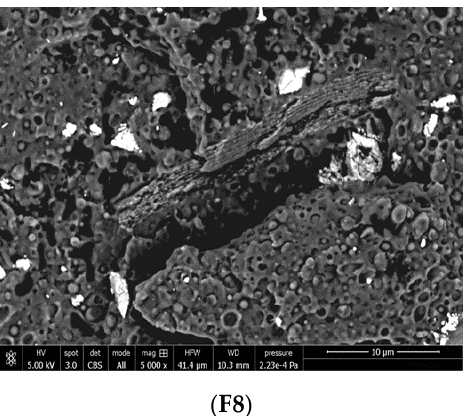
Figure 4. SEM micrographs of F4 , F5 , F6 , F7 , and F8 formulations. The F8 micrographs was obtained by backscattered electrons to better evidence CaCO 3 particles (white).